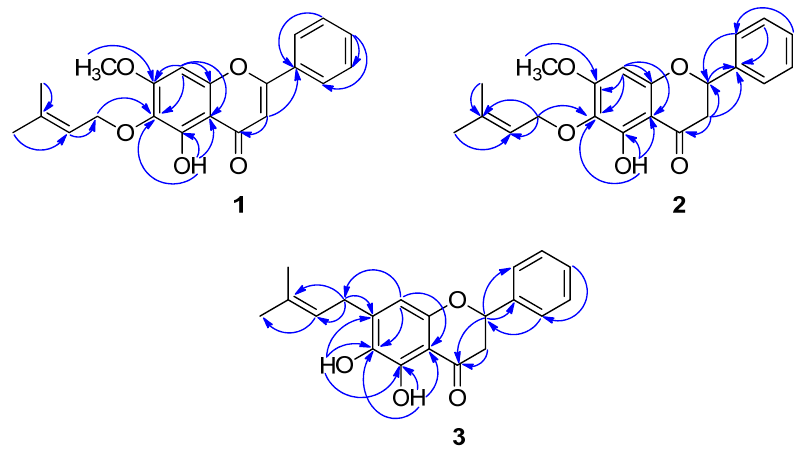
Figure 2. Key HMBC correlations of 1 – 3 .